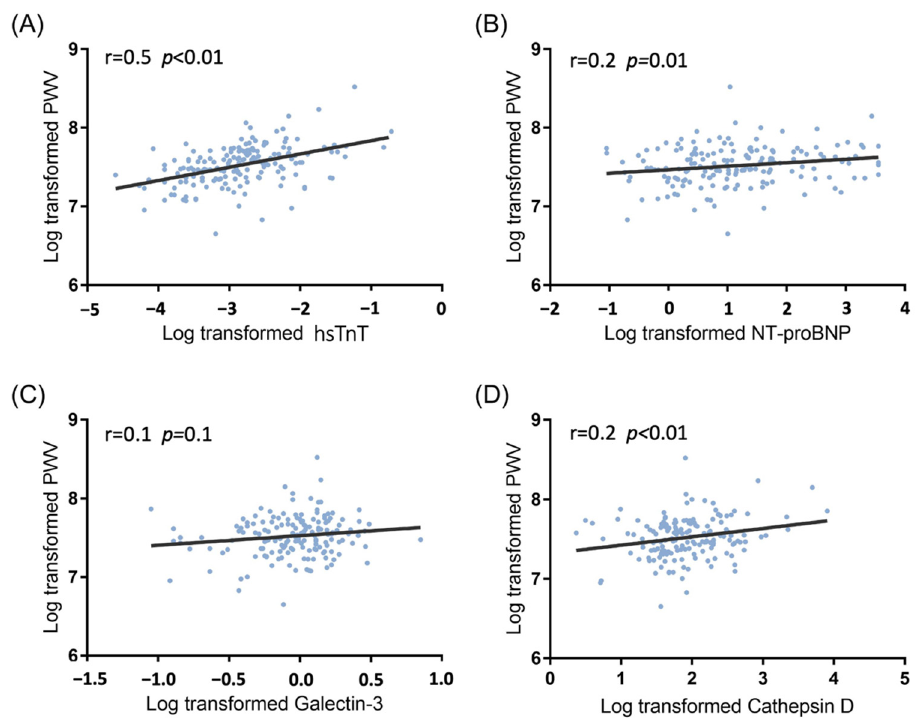
Figure 2. Scatter plots with spline lines demonstrated selected CV biomarkers’ direct association with brachial–ankle pulse wave velocity in hemodialysis patients: ( A ) high-sensitivity troponin T (r = 0.5, p < 0.01); ( B ) N-terminal pro-brain natriuretic peptide (r = 0.2, p = 0.01); ( C ) Galectin 3 (r = 0.1, p = 0.1); ( D ) Cathepsin D (r = 0.2, p < 0.01).